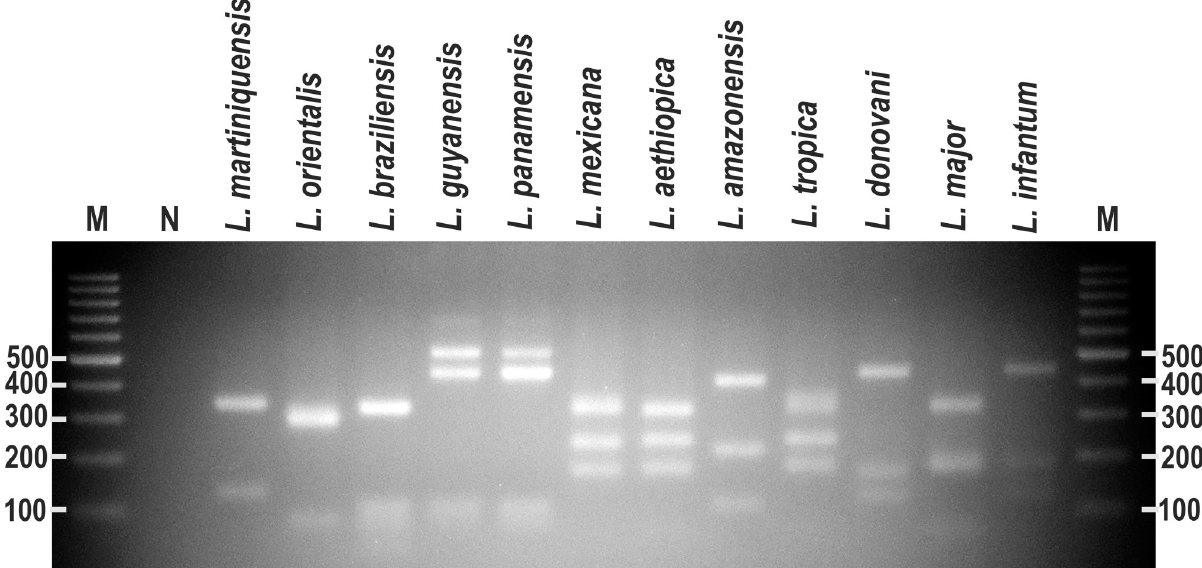
Fig 4. PCR-RFLP analyses of HSP70-I -3 0 -UTR fragments of 12 Leishmania species. PCR amplification was performed with the HSP70-I -3 0 -UTR- specific primers, and PCR products were digested with Bsu RI. M = Molecular markers and N = Negative control.